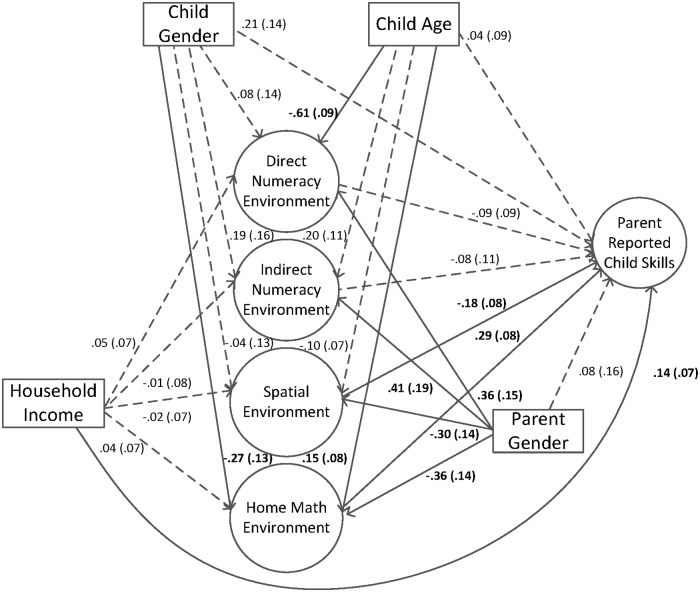
Home math environment factors and household income predicting parent report of child skills.Standard errors are in parentheses. Solid lines and bolded text represent significant pathways, p < .05. Longdash lines represent non-significant pathways, p > .05.